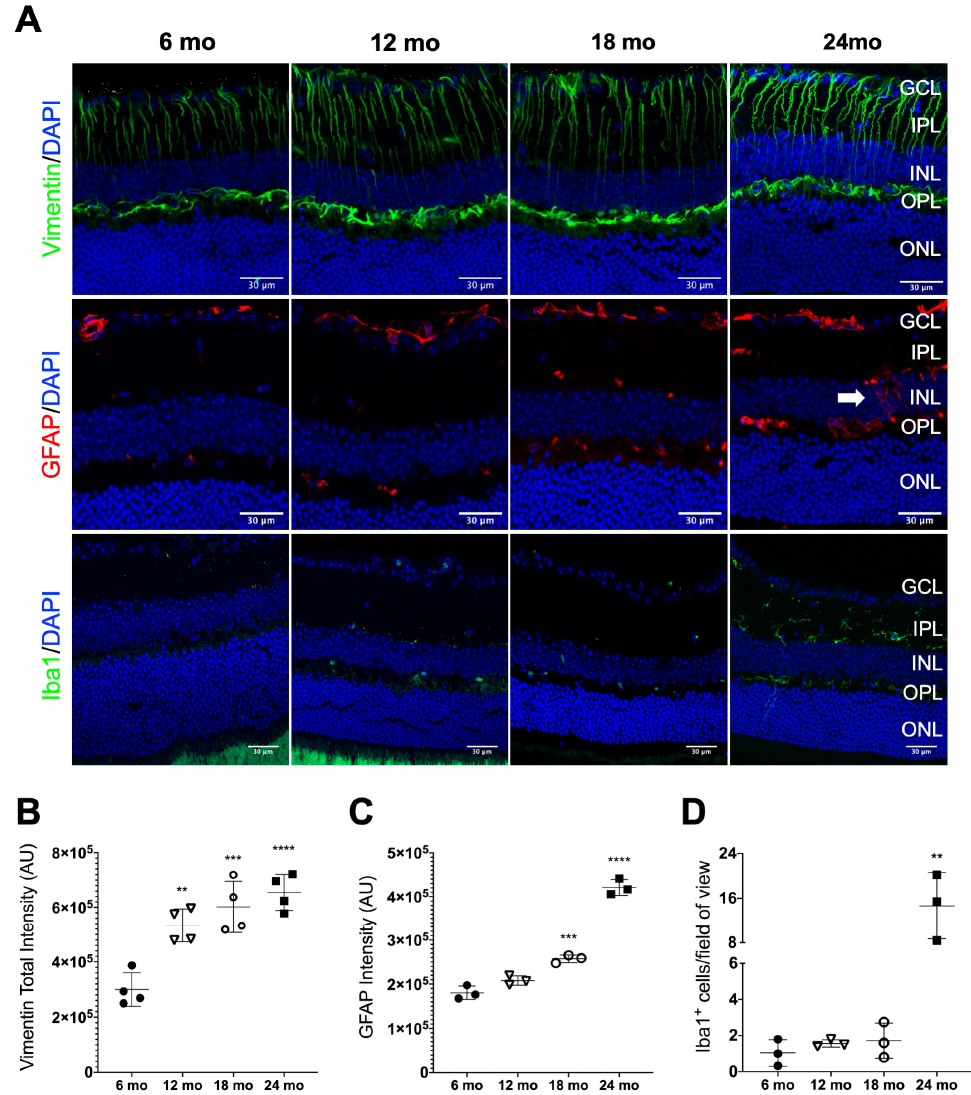
Figure 2. Age-related alterations in glial reactivity assessed by Vimentin, GFAP and Iba1 distribution profile in mice retinas. ( A ) Representative immunofluorescence staining for Müller glia (Vimentin), astrocytes (GFAP) and microglia (Iba1) counterstained with DAPI on retinal sections of mice at the indicated ages. In 24-month-old (mo) mice, GFAP immunoreactivity is prolonged throughout the INL indicated by the white arrow. ( B ) Quantification of vimentin fluorescence intensity throughout the retina for each age ( n = 4). ( C ) Quantification of GFAP fluorescence intensity throughout the retina for each age ( n = 3). Fluorescence intensity analysis was performed using approximately 4 representative images of the central region of the retina from each animal per age group. Values are represented by mean ± SD. Mice of 12 ( ∇ ), 18 ( ○ ) and 24 mo ( ■ ) were compared to 6 mo ( ● ) mice using an ordinary one-way ANOVA multiple comparison test (** p < 0.01, *** p < 0.001 and **** p < 0.0001). Scale bar = 30 mm. ( D ) Quantification of Iba1 + cells detected throughout the retina for each age ( n = 3). Microglia cell counts were performed per field of view of 5 representative images of each group. Values are represented by mean ± SD. Mice of 6, 12 and 18 mo were compared to 24 mo mice using an ordinary one-way ANOVA multiple comparison test (** p < 0.01). In retinal sections of 6-month-old mice, it was possible to visualize a very scarce num- ber of GFAP-positive cells (Figure 2A). As age advanced, GFAP immunoreactivity in-